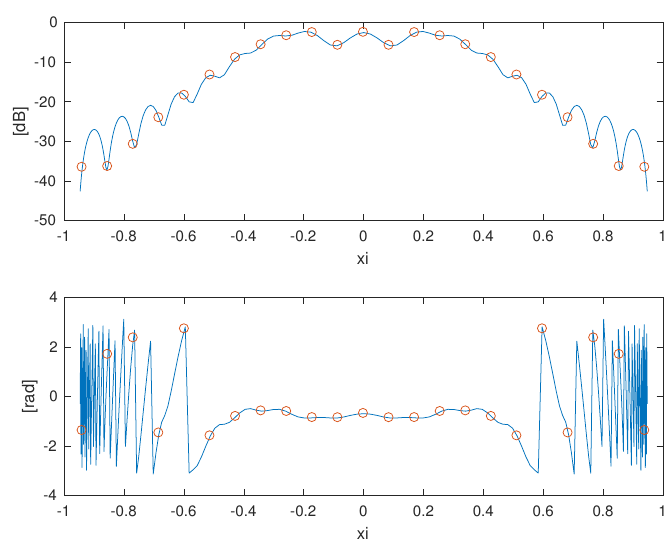
Figure 8. Near field amplitude ( top ) and phase ( bottom ) along the observation line plotted according to the ξ observation curve parameterization; the sampling points using the minimum redundant spatial sampling strategy are plotted as circles.